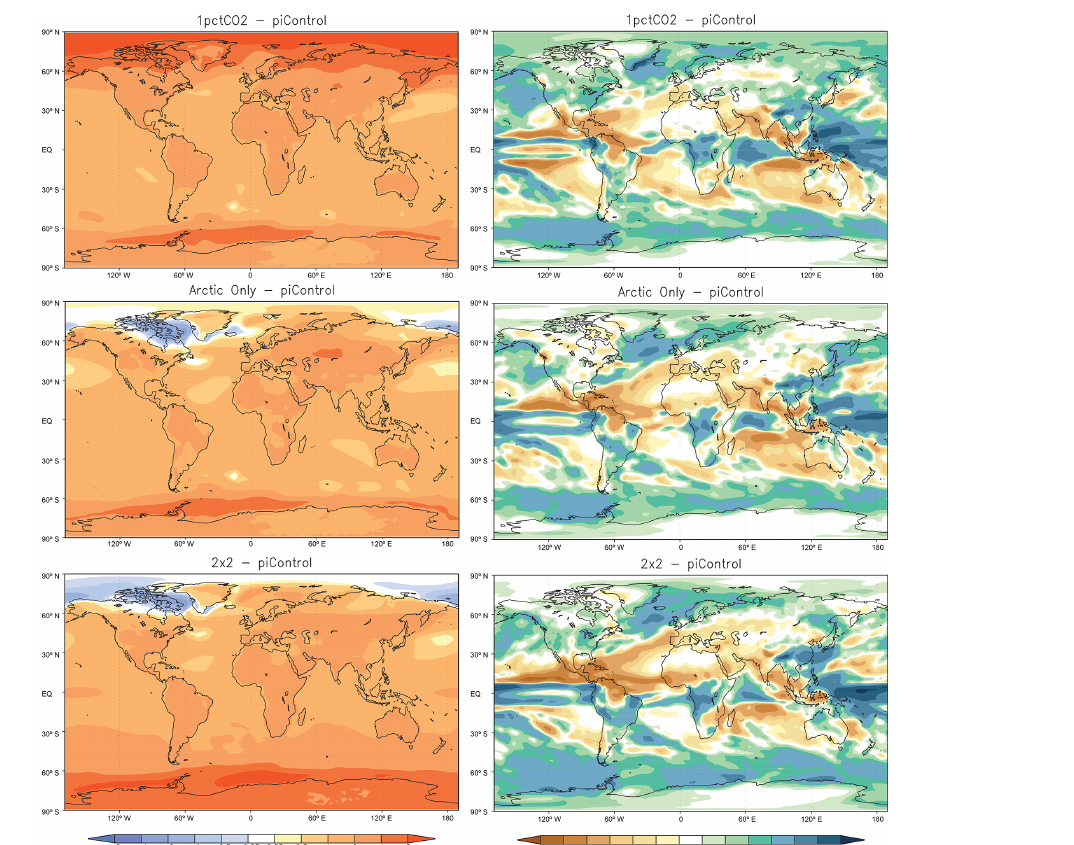
Figure 13. Maps of temperature change (left column panels; ◦ C) and precipitation change (right column; mmday − 1 ) for the 2 × 2 case in the design model. Changes are calculated from the average of a preindustrial control simulation. The top panel corresponds to a 1pctCO2 simulation, middle row panels indicate simulations in which only Arctic insolation is adjusted, and bottom row panels indicate the full 2 × 2 case. All panels are averages over the last 10 years of a 70-year